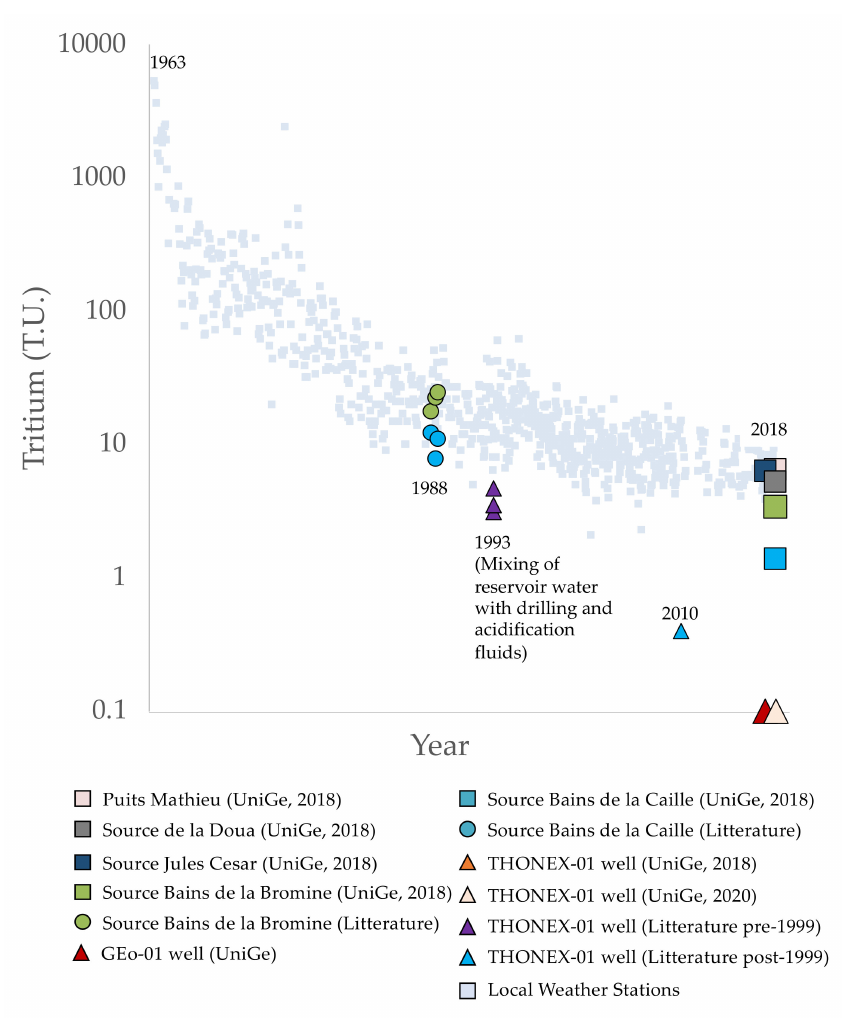
Figure 14. Tritium data series reporting the concentration at sampled waters with respect to the Thonon weather